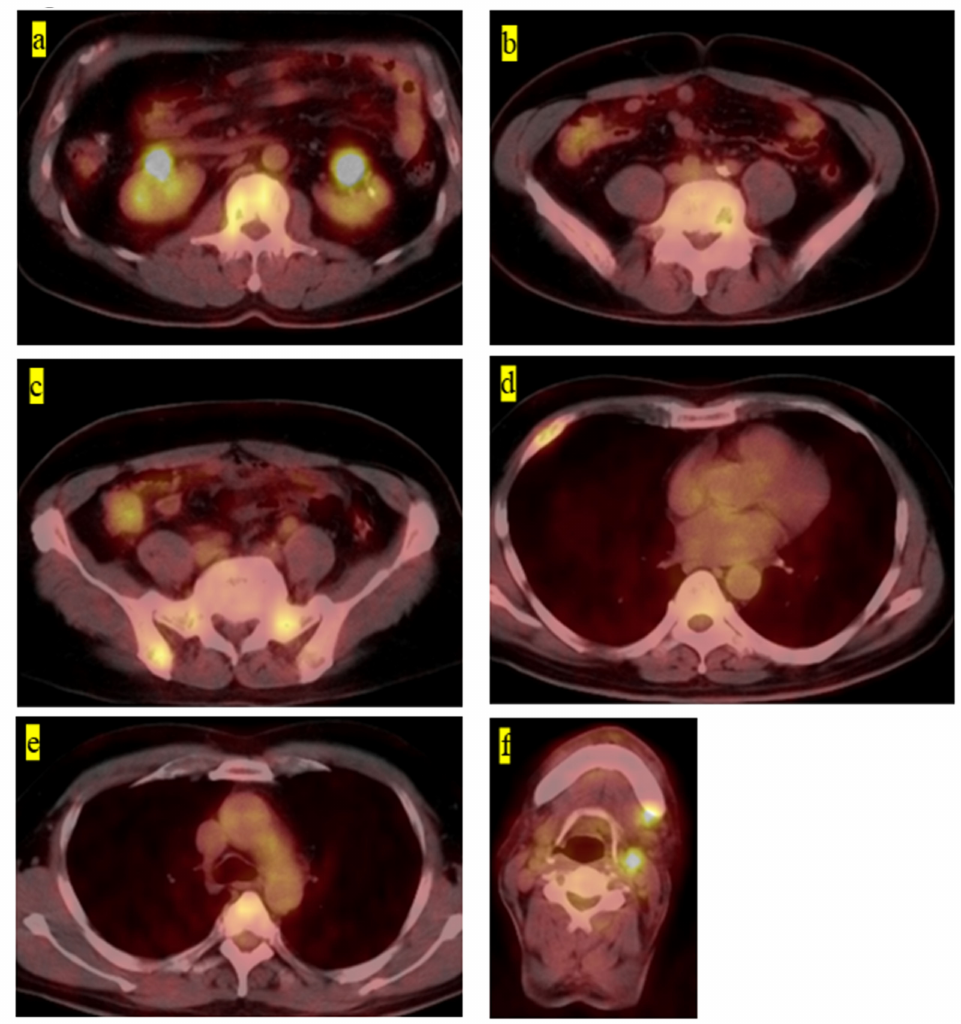
Figure 2. ( a ) Fluorodeoxyglucose-positron emission tomography–computed tomography image showing the accumulation on the fourth lumbar vertebra, ( b ) fifth lumbar vertebra, ( c ) right pelvic bone, ( d ) right fourth rib, ( e ) fifth thoracic vertebra, and ( f ) left neck and left submandibular